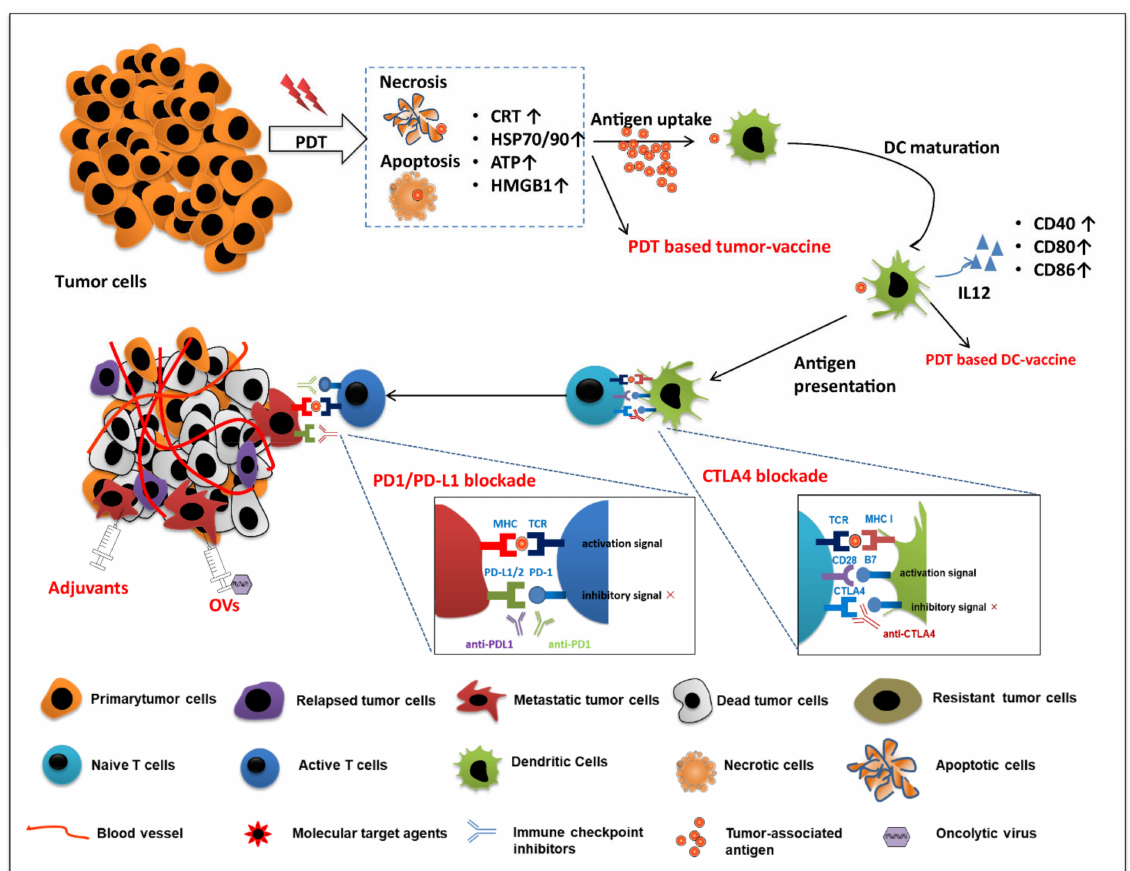
Figure 6. NP-mediated photodynamic therapy in combination with various immune therapies, including vaccination, immune checkpoint inhibitors, oncolytic viruses (OVs), and adjuvants. The combination works to enhance the key factors of the immune-oncology cycle—antigen release, antigen presentation, APC activation, T-cell activation, T-cell infiltration, and antigen recognition—to kill primary tumor cells and overcome tumor recurrence and